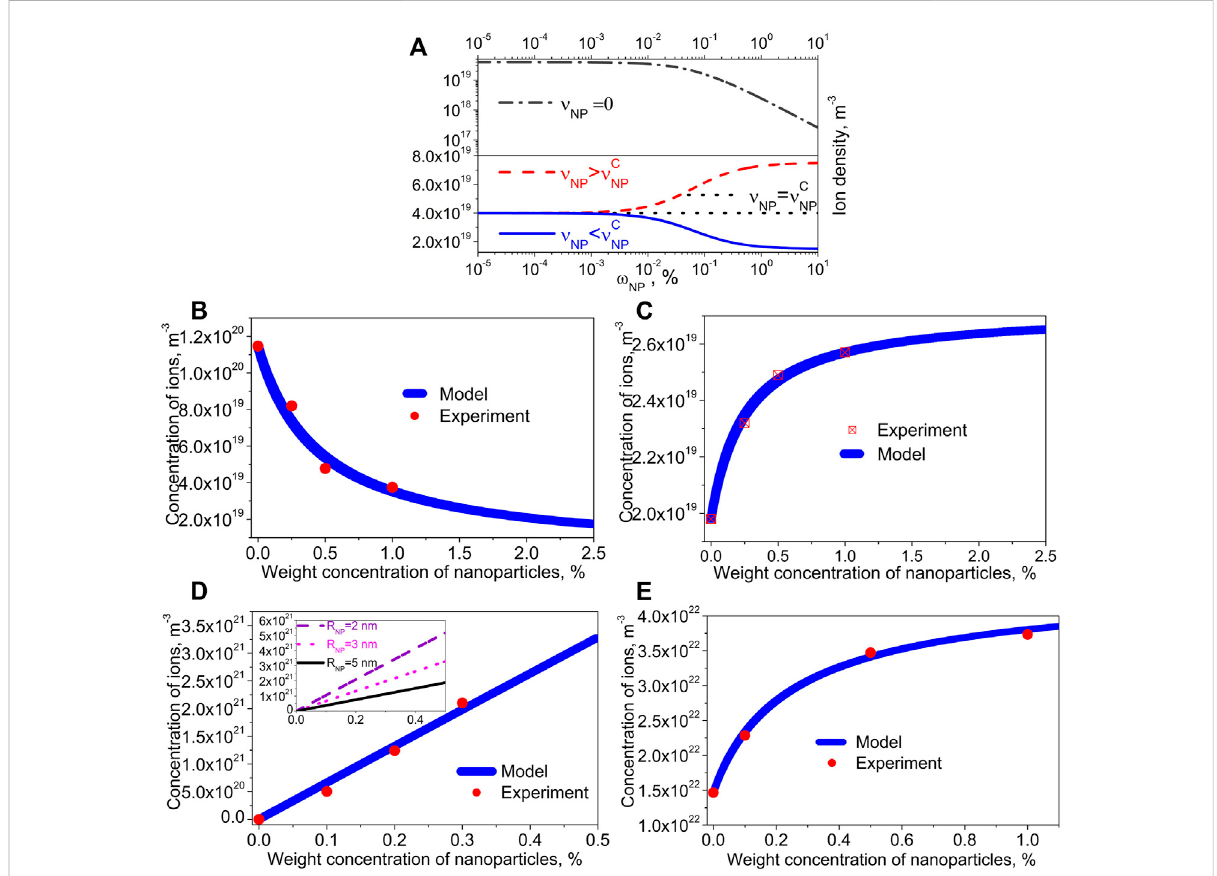
FIGURE 1 (A) Thedependenceofthebulkiondensityontheweightconcentrationofnanoparticles ω NP . (B) and (C) Thedependenceoftheconcentration ofionsinliquidcrystalsdopedwith TiO 2 nanoparticlesontheweightconcentrationofnanodopants.Experimentaldatapointsarefrom(Shcherbinin and Konshina, 2017a). (D) The concentration of ‘ slow ’ ions in liquid crystals doped with CdSe/ZnS quantum dots as a function of the weight concentrationofnanodopants.Experimentaldatapoints arefrom(Shcherbininand Konshina,2017b). (E) Thedependence oftheconcentration ofionsinliquidcrystalsdopedwith Cu 7 PS 6 nanoparticlesontheweightconcentrationofnanodopants.Experimentaldatapointsarefrom(Kovalchuk et al., 2017). Reproduced from (Garbovskiy, 2018b), under the Creative Commons Attribution